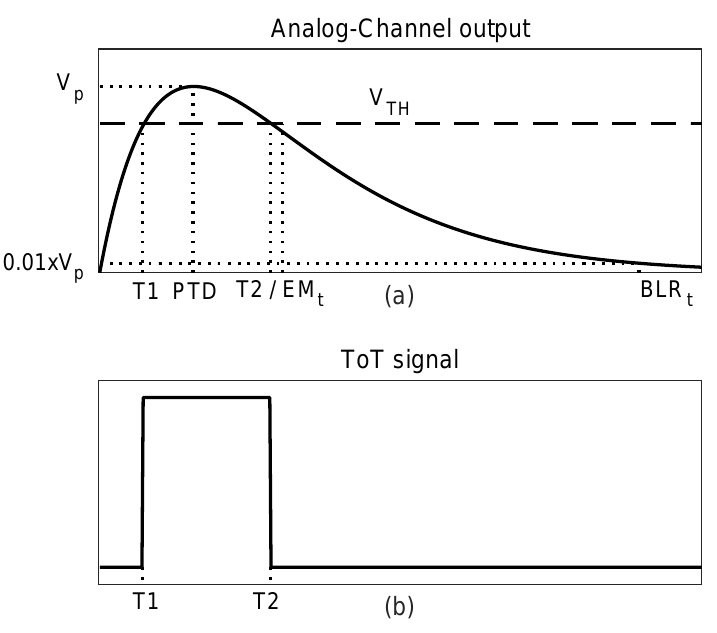
Figure 2. ( a ) Analog-channel output waveform indicating PTD, EM and BLR times; and ( b ) extracted ToT signal from the analog-channel